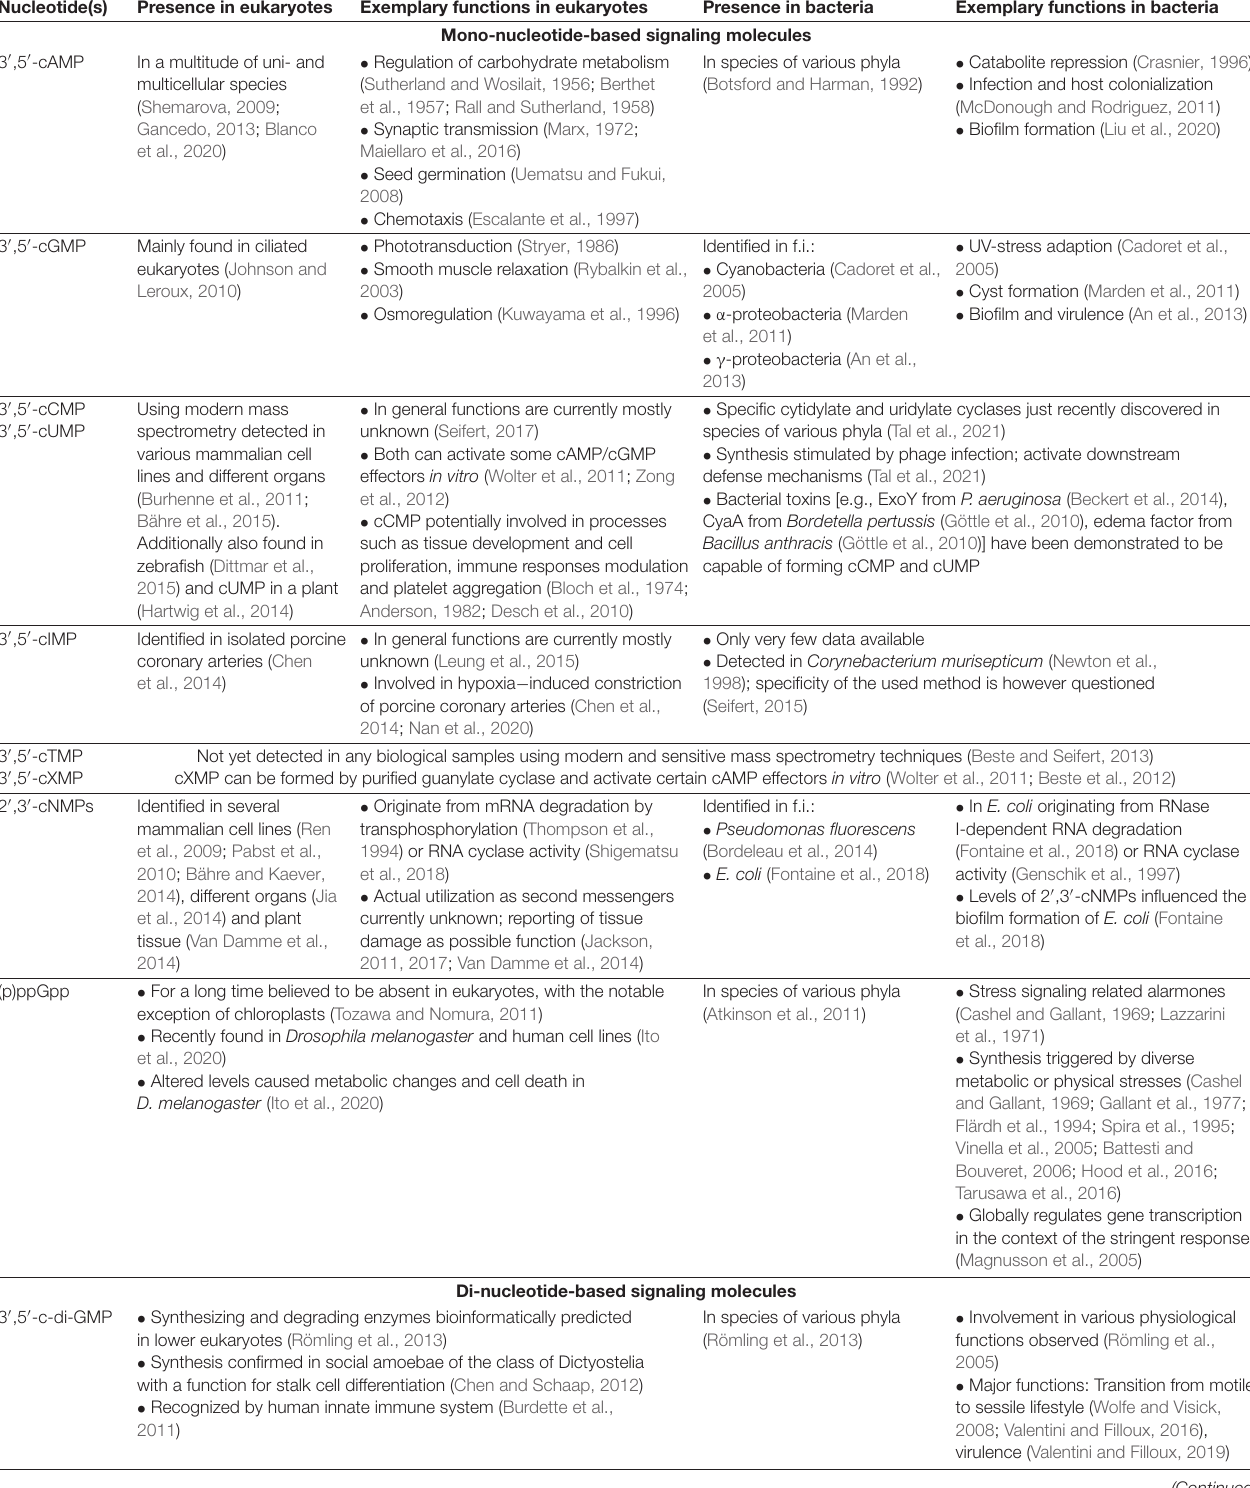
TABLE 1 | Overview on occurrence and exemplary function(s) in eukaryotes and bacteria of all signaling nucleotides addressed in this study. Nucleotide(s) Presence in eukaryotes Exemplary functions in eukaryotes Presence in bacteria Exemplary functions in